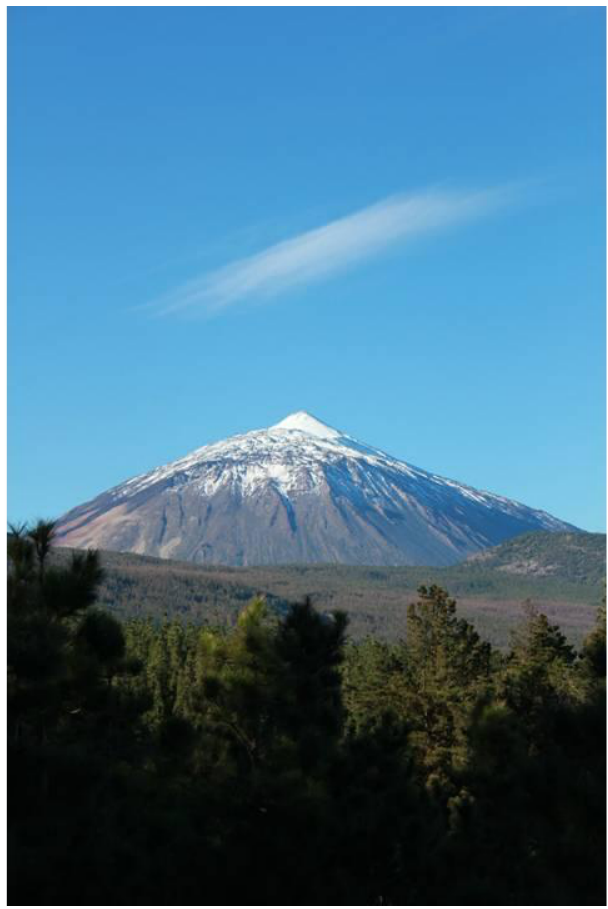
Fig. 1. The stratovolcano Teide in Tenerife, Canary Islands. View looking southwest, the summit of El Pico del Teide is at 3710ma.s.l. The volcano as seen here stands about 1800m above its surroundings, has steep slopes, and is composed of numerous lava flows, pyroclastic and sedimentary layers, and intrusions of various types and mechanical properties (cf. Figs. 3 and